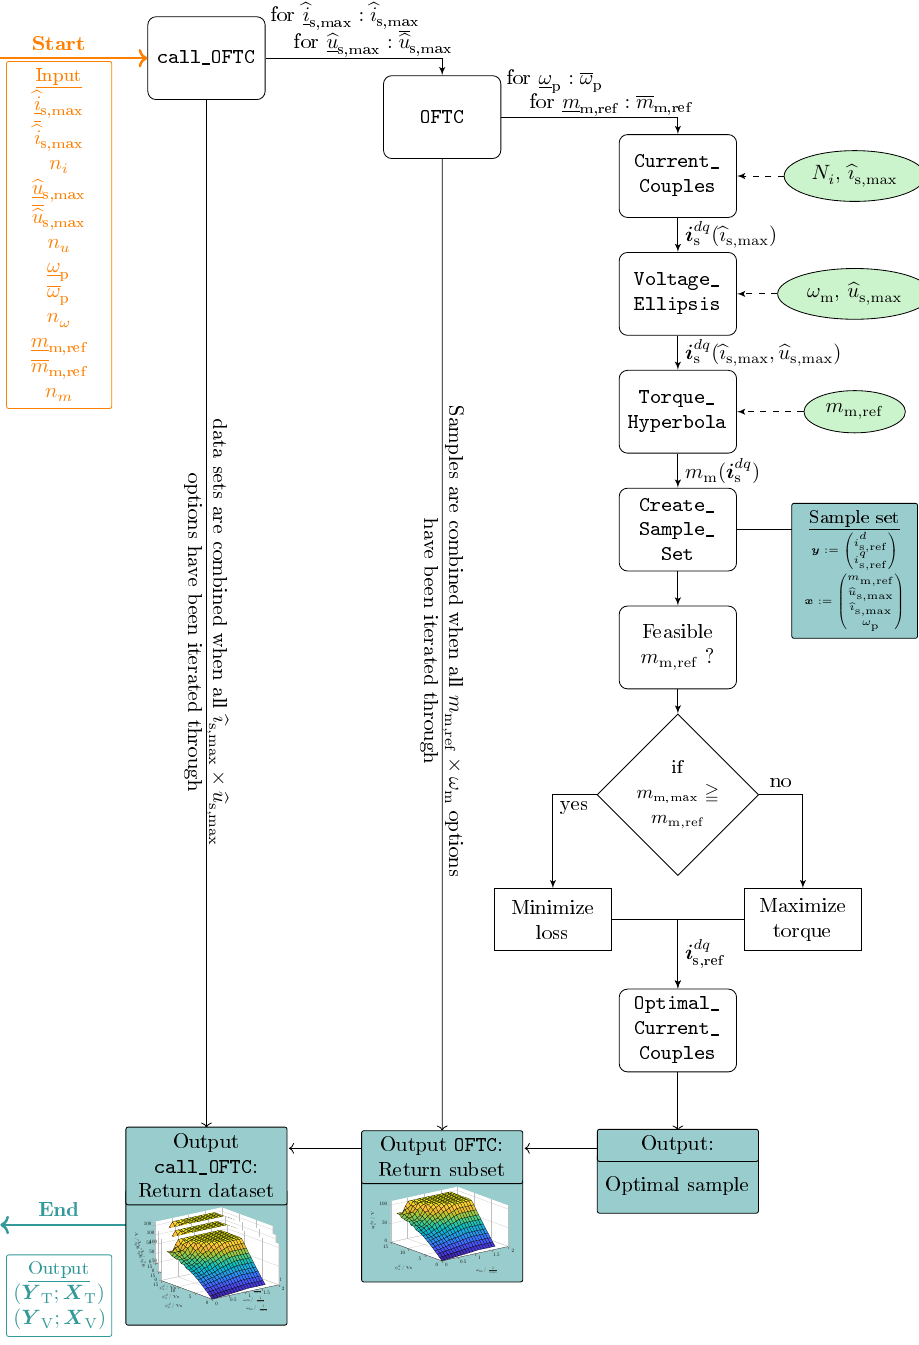
, n , n and n , ω i u m